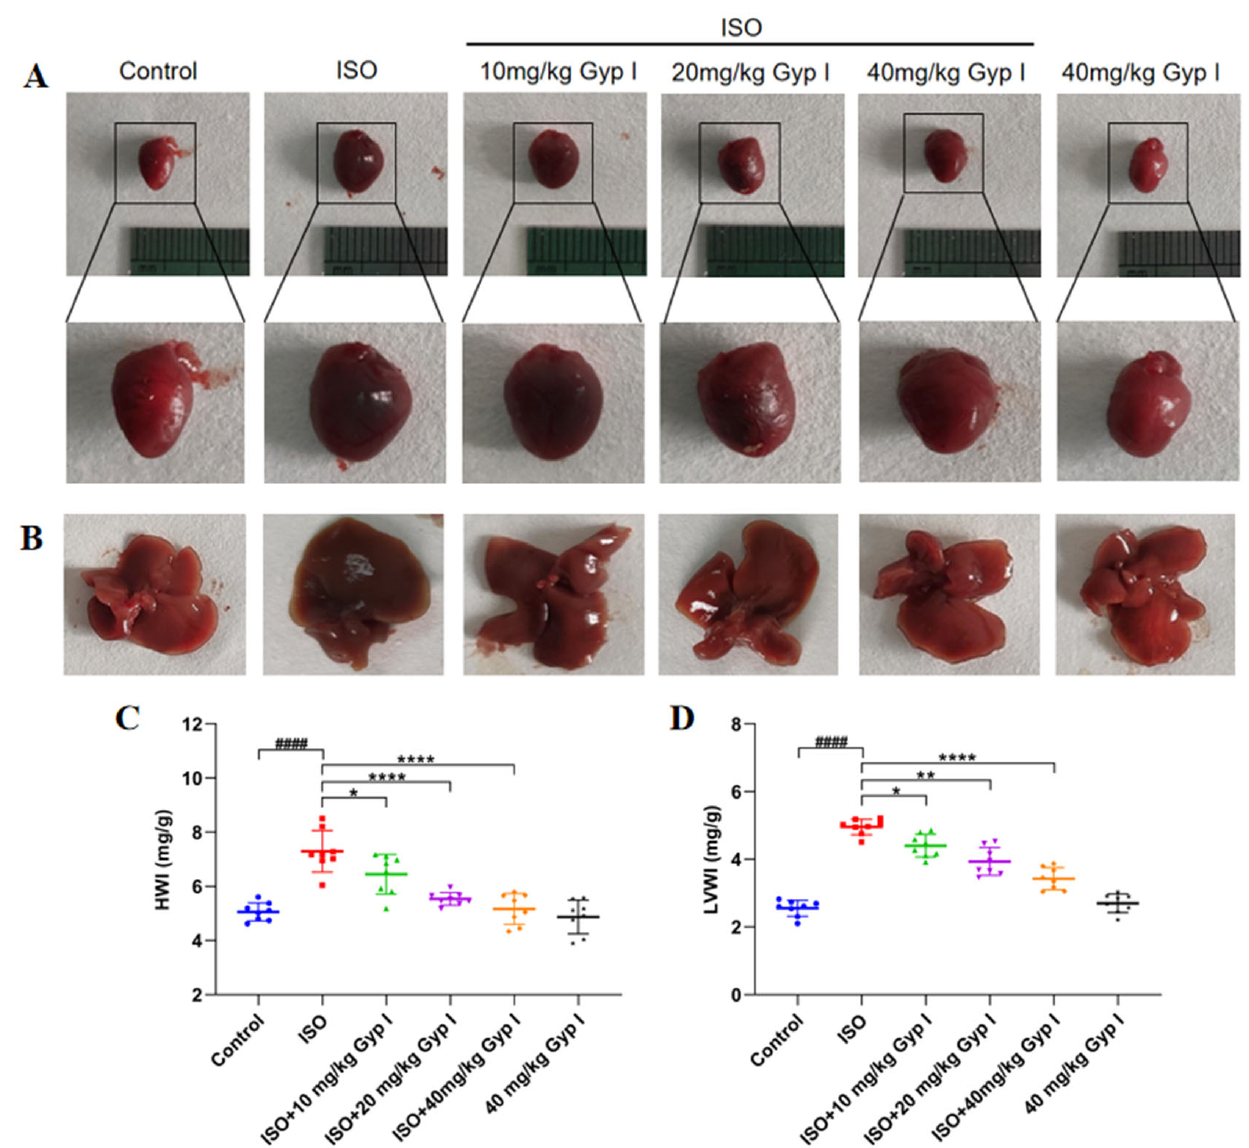
Figure 5. Effects of Gyp I on heart and liver morphology; HWI and LVWI of ISO-induced mice: ( A ) Cardiac morphology. ( B ) Liver morphology. ( C ) HWI. ( D ) LVWI. Analysis was conducted using one-way ANOVA followed by Tukey’s multiple-comparison test ( n = 8, mean ± SD, ####: p < 0.0001 compared with Control group; *: p < 0.05, **: p < 0.01, ****: p < 0.0001 compared with ISO